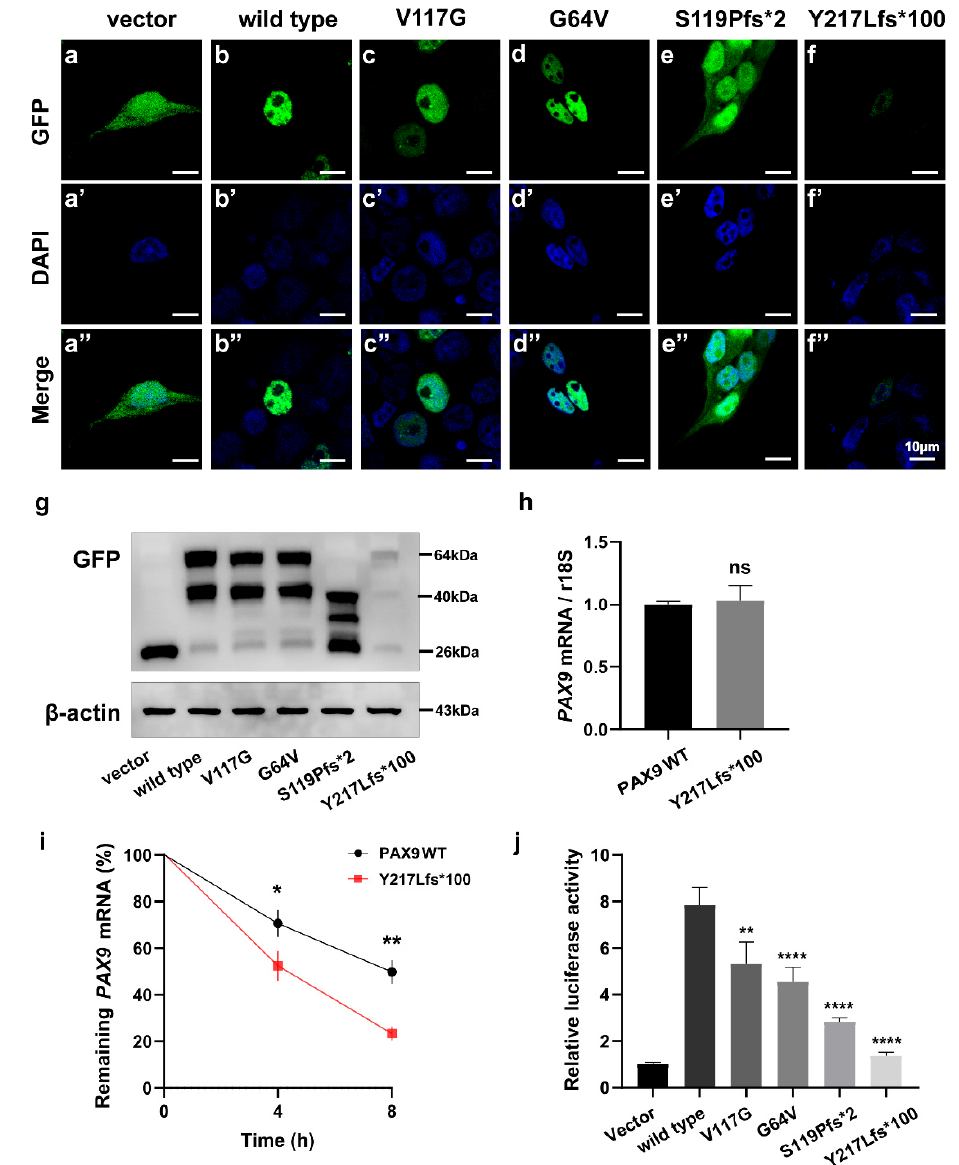
Figure 3. Functional studies of variant PAX9 proteins. ( a – f ) Subcellular localization of wild-type or variant PAX9 in vitro. ( a’ – f’ ) Nuclei staining by DAPI, 4,6-diamino-2-phenylindole. ( a” – f” ) Merging of GFP and DAPI. MSX1 (GFP, green); nuclei (DAPI, blue). ( g ) Western blot analysis of wild-type or variant PAX9 using anti-GFP and anti- β -actin antibodies. An empty vector was transfected as a negative control. ( h ) Relative messenger RNA (mRNA) expression levels of variant PAX9 at 12 h after transfection. Data were statistically analyzed by the Student’s t -test. n =3. ns, no significance. ( i )